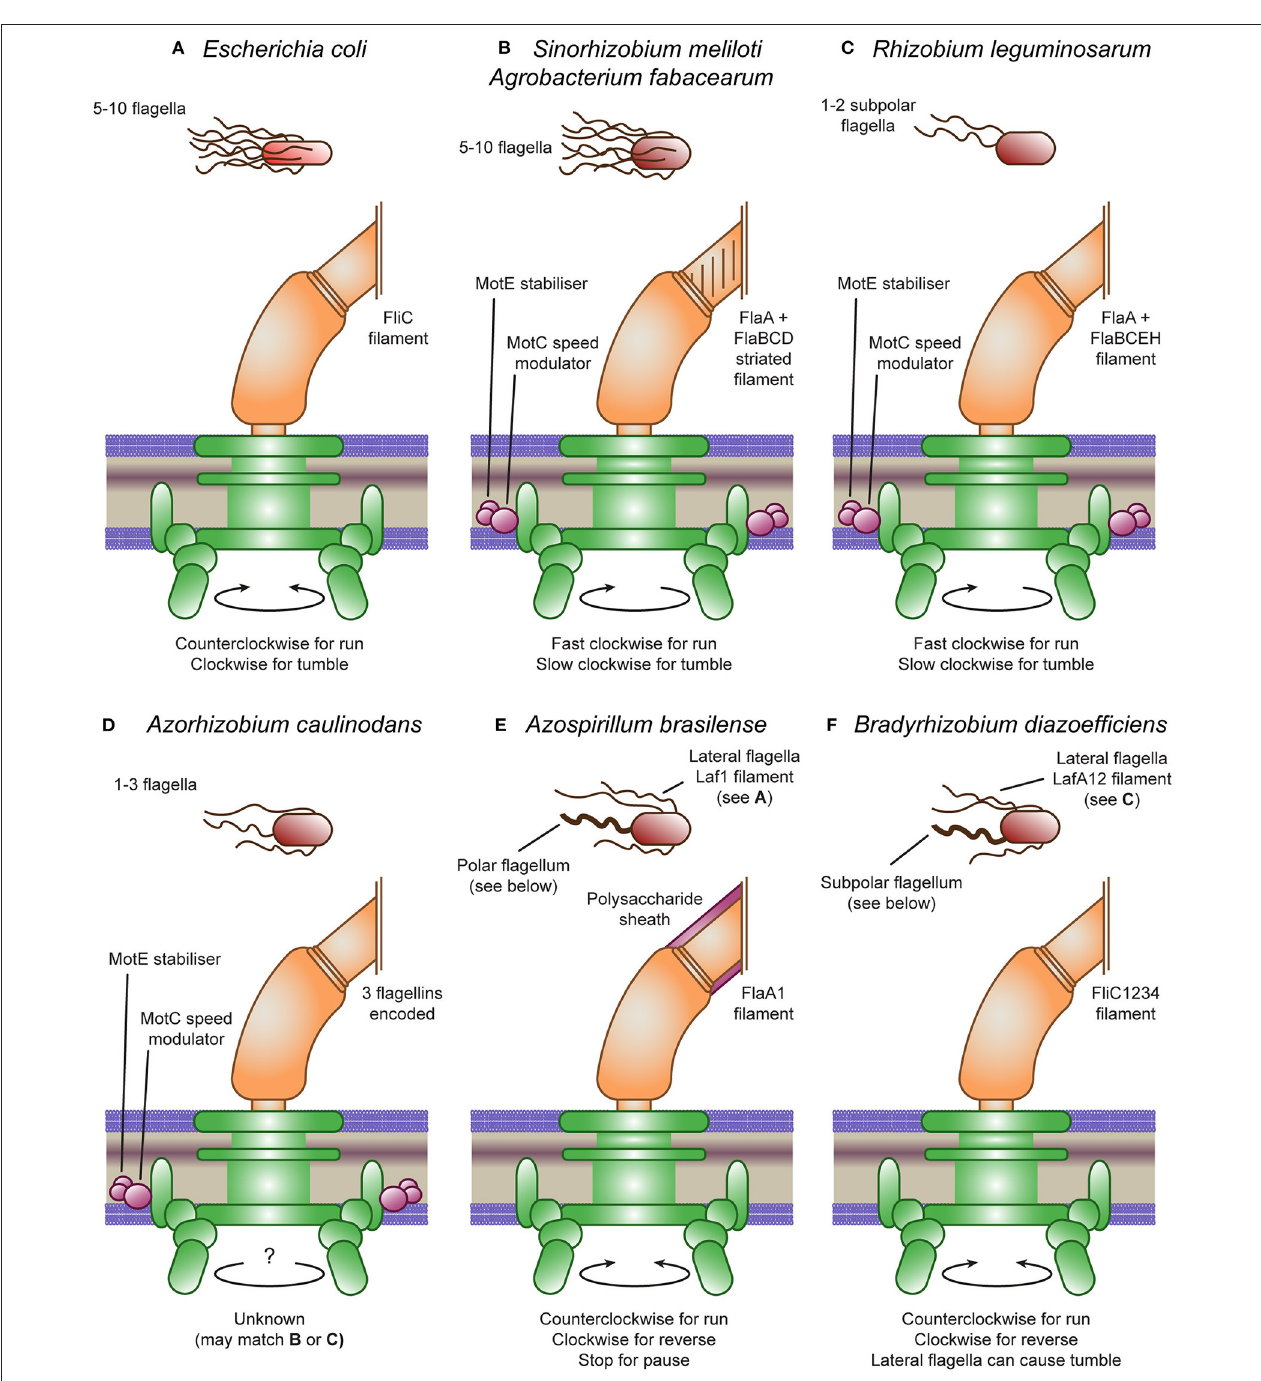
FIGURE 1 | Escherichia coli and rhizobial motility models. (A) The E. coli peritrichous flagella provides thrust through counterclockwise rotation and tumbles through clockwise rotation causing the flagella bundle to dissociate. (B) The Sinorhizobium meliloti and Agrobacterium fabacearum peritrichous flagella provide thrust through clockwise rotation and tumbles through speed modulation causing the flagella bundle to dissociate. This speed modulation is controlled by MotC, stabilized by MotE. The reversed direction is due to the heterogeneous filament proteins producing a right-handed striated filament. (C) The Rhizobium leguminosarum subpolar flagella also provide thrust through clockwise rotation and tumbles through speed modulation, although they do not form a flagella bundle. The R. leguminosarum flagella also have heterogeneous filaments, although they are not visibly striated. (D) The Azorhizobium caulinodans flagella are not well-studied but may match either (B) or (C) , having the MotC and MotE accessory proteins. (E) Azospirillum brasilense produces two flagella types: a polar flagellum covered by a polysaccharide sheath that provides thrust through counterclockwise rotation, reverses through clockwise rotation and can pause by stopping the motor; and lateral flagella matching (A) . (F) Bradyrhizobium diazoefficiens produces two flagella types: a subpolar flagellum that provides thrust through counterclockwise rotation and reverses through clockwise rotation; and lateral flagella matching (C) that can cause tumbles.